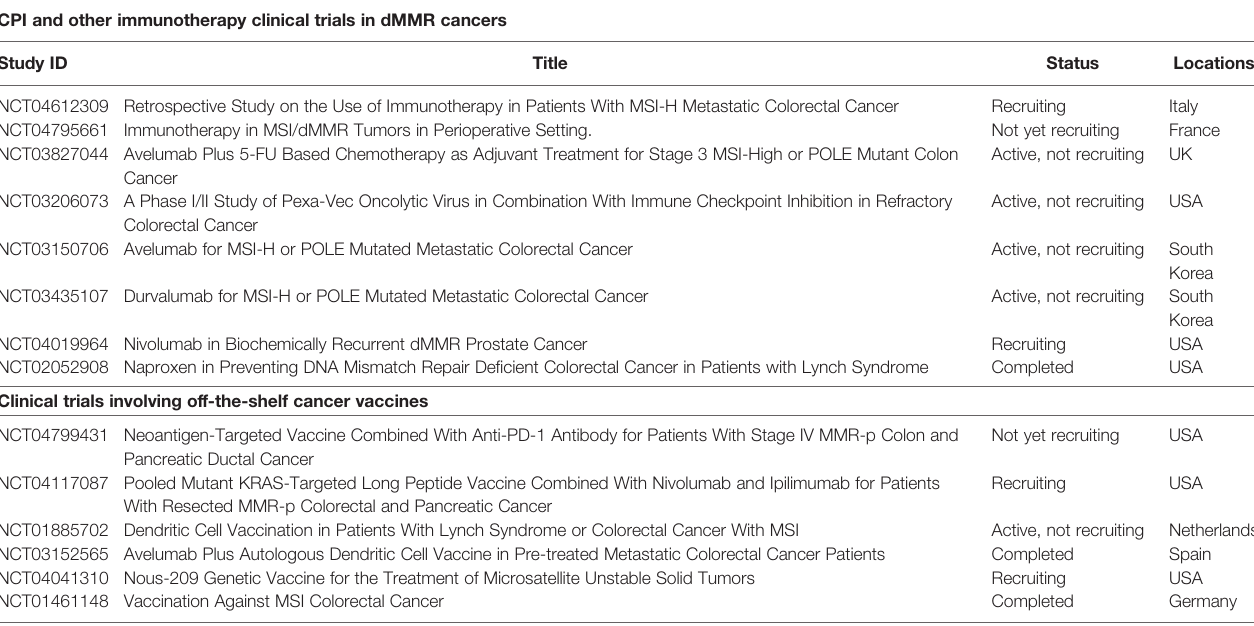
TABLE 1 | List of registered clinical trials of cancer vaccines and/or CPI in dMMR/Lynch syndrome patients. CPI and other immunotherapy clinical trials in dMMR